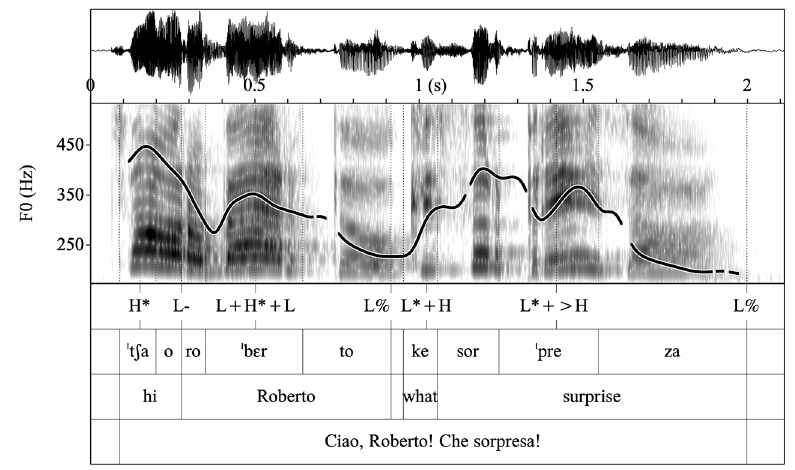
Figure 6. Waveform, spectrogram and F0 trace of the what -exclamative statement Hi, Roberto! What a surprise! in L1 Italian produced with L*+>H L%.